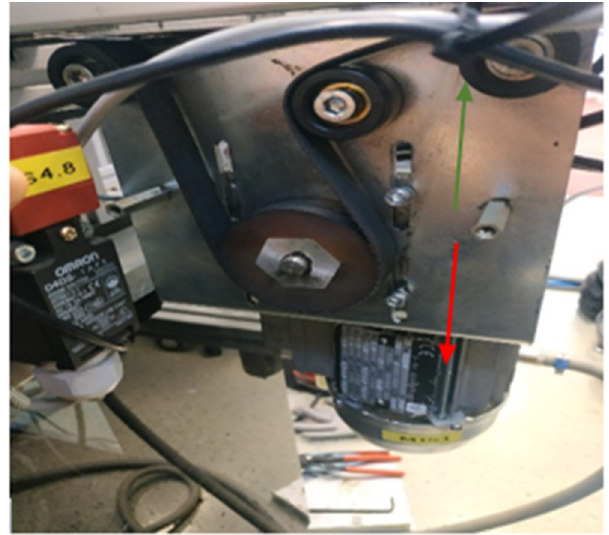
Figure 6. Motor driver with head pulley at main conveyor.